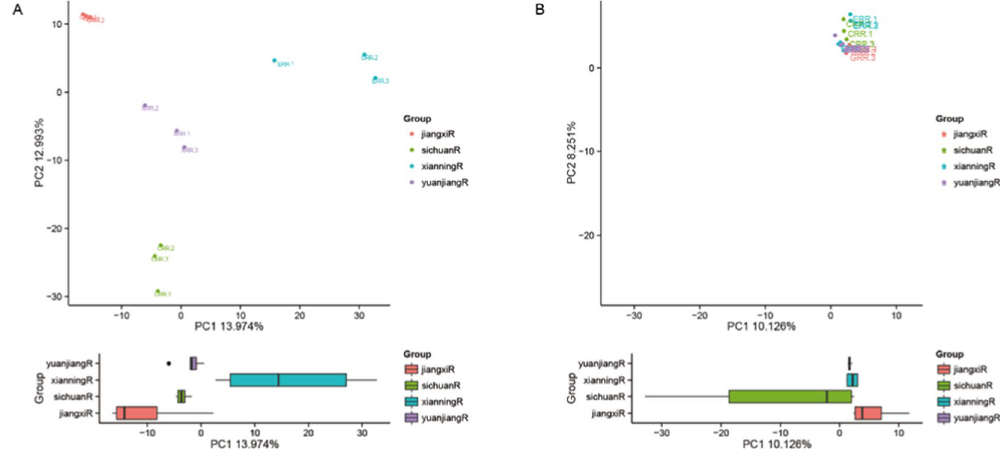
Figure 4. PCA of the OTUs detected major variations in the bacterial ( A ) and fungal ( B ) communities in four different area continuous cropping ramie soil samples.